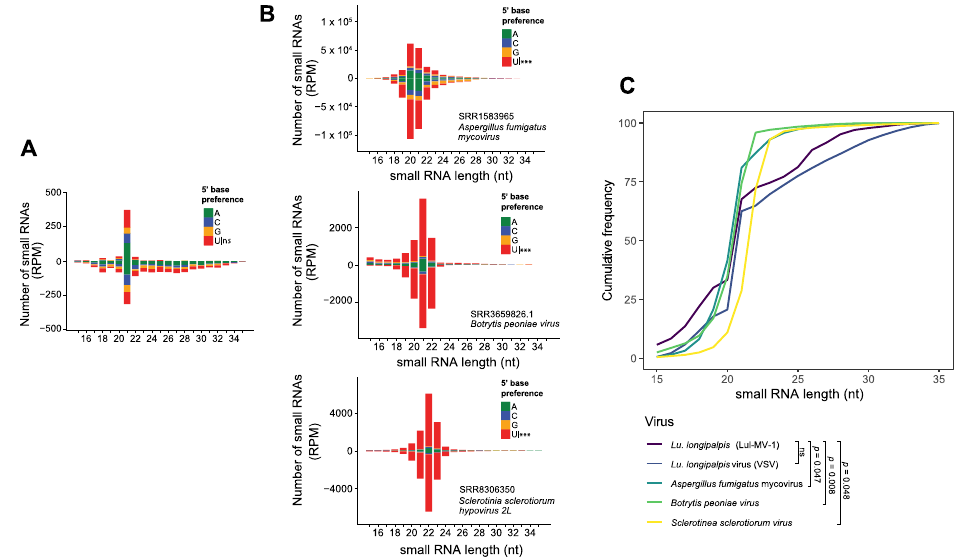
Figure 6. Characterization of small RNAs derived from Lu. longipalpis and fungi-related viruses. ( A ) Small RNA size profiles and 5′ base preference of small RNAs derived from Lul-MV-1 and ( B ) fungi-related viruses (from top to bottom: Aspergillus fumigatus mycovirus, Botrytis paeoniae virus and Sclerotinia sclerotiorum hypovirus). 5′ base preferences of small RNAs are indicated by color. Significant differences are also indicated. ( C ) Cumulative frequency according to the size distribution of small RNAs varying from 15 and 35 nt, derived from viruses infecting Lutzomyia (Lul-MV-1 and VSV) and fungi. Statistical significance among cumulative frequencies was determined using the Kolmogorov-Smirnov test.